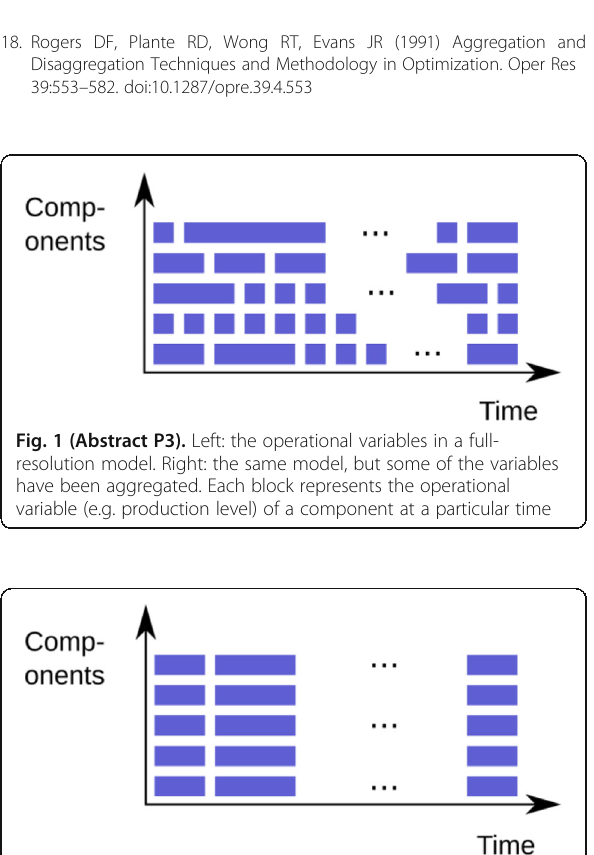
Fig. 2 (Abstract P3). Left: segmentation, where adjacent time steps have been aggregated for all components. Right: representative time periods. In this example, we have three representative time periods indicated by three different